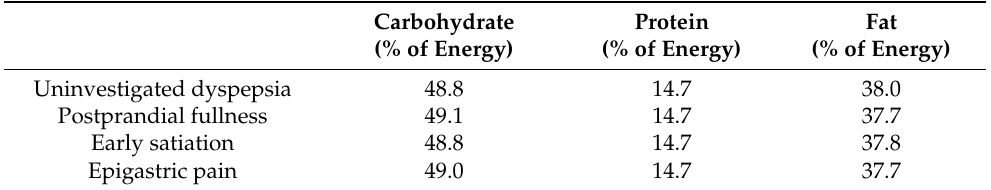
Table 6. Calculated macronutrient intakes to predict uninvestigated dyspepsia and its symptoms in generally healthy adults.